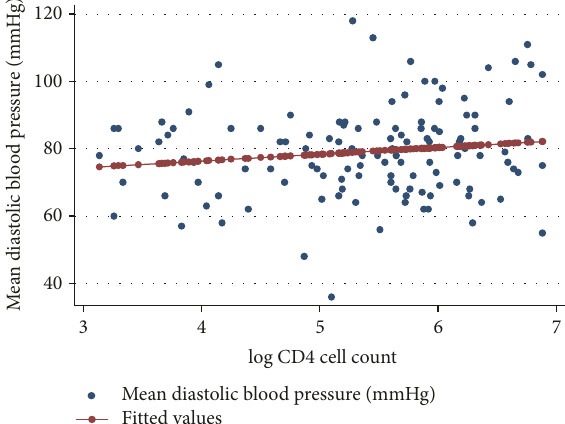
Figure 1: Scatter plot for mean systolic blood pressure and log CD4 cell count. The red line represents the prediction line of the regression model.